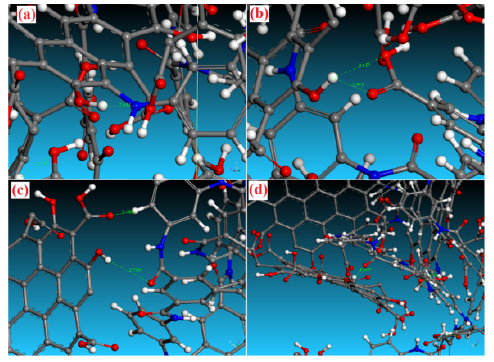
Figure 18. The formation of H-bonds between the GQDs and the PA chain functional groups [35].